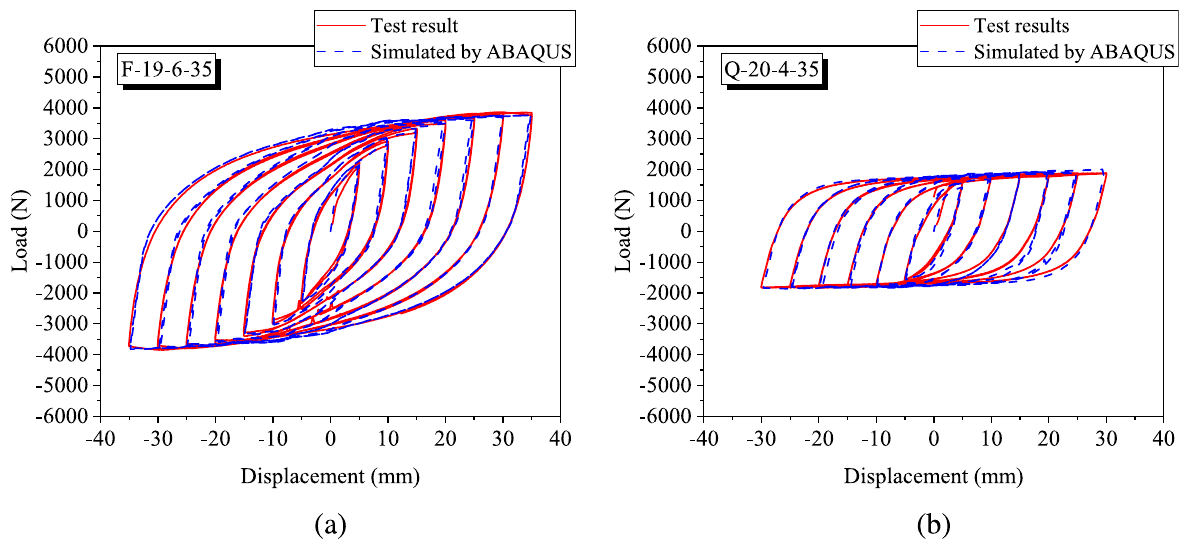
Fig. 15 Representative comparison between test results and finite element simulation result of USS